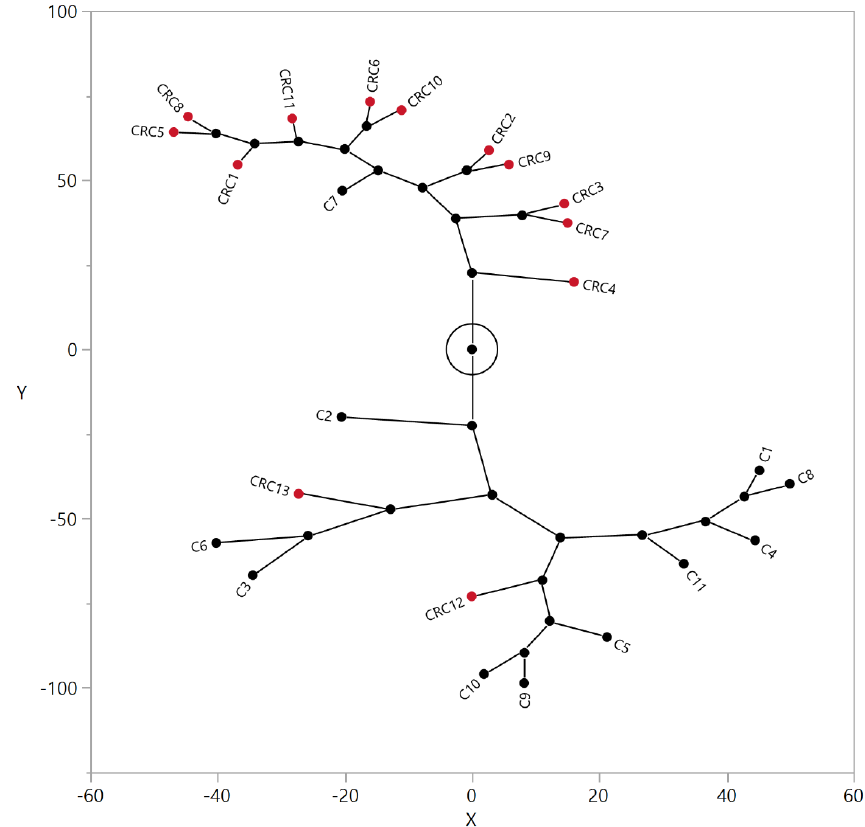
Figure 4. Constellation plot generated for the N-glycans in the blood serum of CRC patients and control individuals. The normalized and standardized -CH 3 /-CD 3 ratios for fifty-three (53) N-glycans obtained by LC-MS/MS analyses of the blood serum of CRC patients ( • ) and control individuals ( • ) were submitted to a hierarchical clustering algorithm using the Ward’s method and the resulting dendrogram was depicted as a constellation plot. X and Y axes are dimensionless.